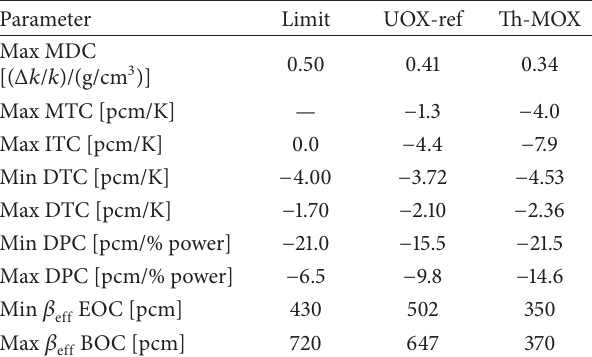
Table 2: Key safety parameters, their limits, and the calculated values for the Th-MOX and the reference UOX core. No limit is specified for moderator temperature coefficient in Ringhals